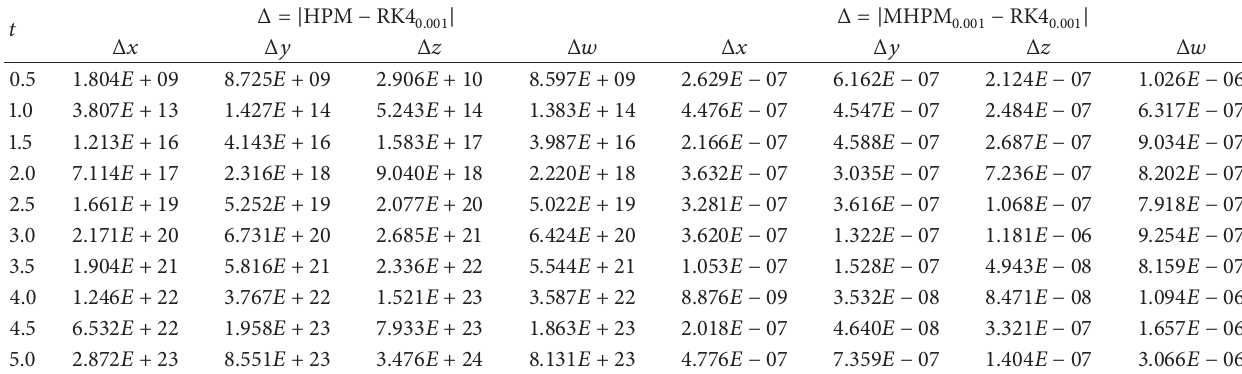
Table 8: Differences between 15-term HPM and 15-term MHPM with RK4 solutions on Δ𝑡 = 0.001